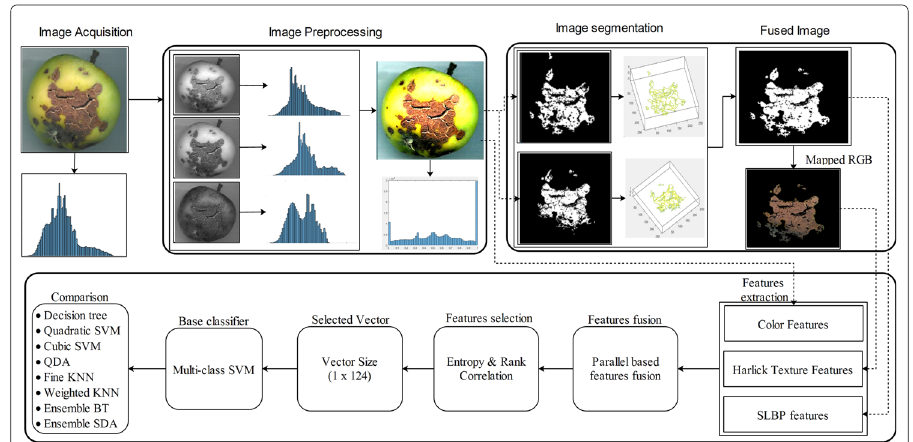
Fig. 1 A proposed framework of detection and classification of diseases in the plants and fruits